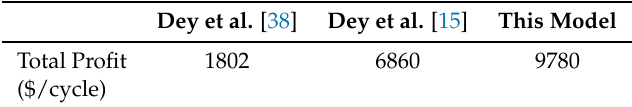
Table 7. Comparison of total profit with previous